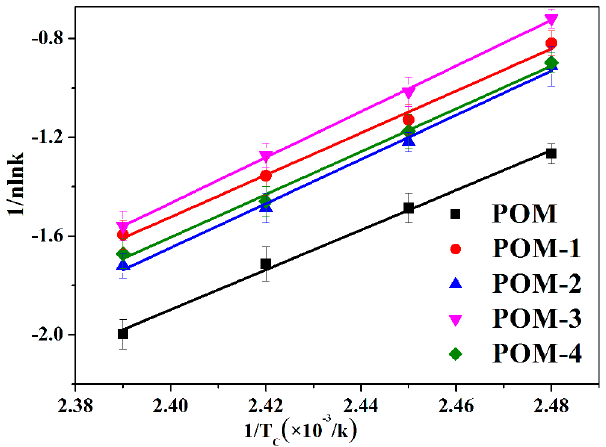
Figure 10. Plots of 1/ n ln k versus 1/ T C for the POM/Ag nanocomposites. Table 6. Isothermal crystallization activation energy of POM/Ag nanocomposites.